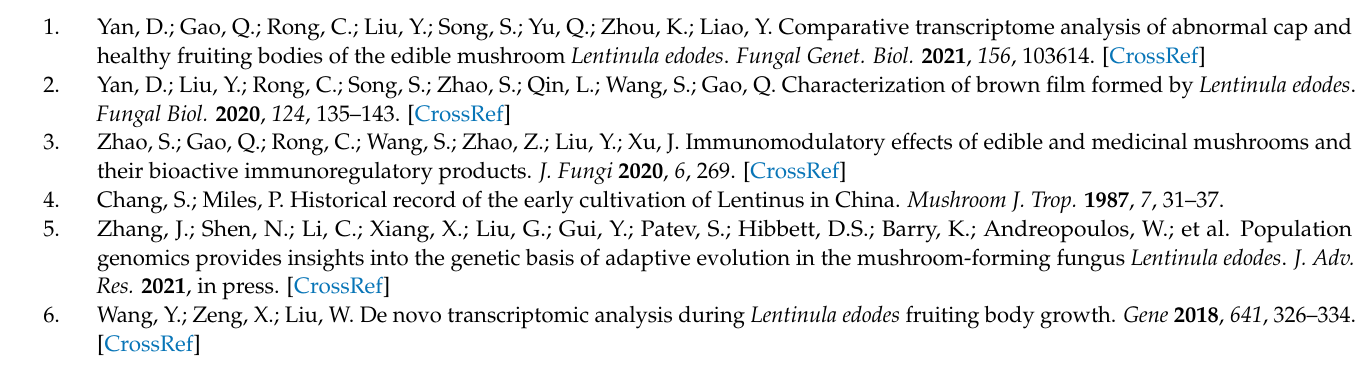
assembly process. Figure S2: Whole-genome Hi-C interaction map at 50 k resolution; Figure S3: 3D image of chromosome structure during cell fusion within the basidia of the dikaryon formed mating strains SP3 and SP30; Figure S4: Dot plot of collinearity between SP3 and SP30; Figure S5: The distribution of SNP across the SP3 and SP30 chromosomes; Figure S6: Locations of the two monokaryon strains’ rearranged genes on each chromosome; Figure S7: PCR verification of selected unique genes; Figure S8: Differences in new homeodomain transcription factors (HD) of six strains of Lentinula edodes ; Figure S9: CAZymes classification; Figure S10: Colony morphology and growth differences between the two monokaryons and their mating product dikaryon 3 × 30; Table S1: Contig numbers and length of pseudo chromosome within each of the two sequenced monokaryons; Table S2: Statistics of repeat sequence types in each genome; Table S3: Summary statistics of functional gene annotations based on information from different databases; Table S4: Annotation statistics of non-protein coding RNA with each of the two genomes; Table S5: Information of publicly available genomes of four monokaryotic strains used in collinearity analyses; Table S6: Top 20 GO term analysis of synteny genes; Table S7: Top 20 KEGG term analysis of synteny genes; Table S8: CAZyme cluster genes that are not syntenic between strains SP3 and SP30; Table S9: GO term analysis of rearranged genes between SP3 and SP30; Table S10: KEGG term analysis of rearranged genes between SP3 and SP30; Table S11: Unique genes and primers for PCR analysis. Table S12: PCR and Sanger sequencing identity of the unique genes within each of two genomes. Table S13: The numbers of retrotransposons belonging to various long-terminal repeat (LTR) superfamilies in the two monokaryotic